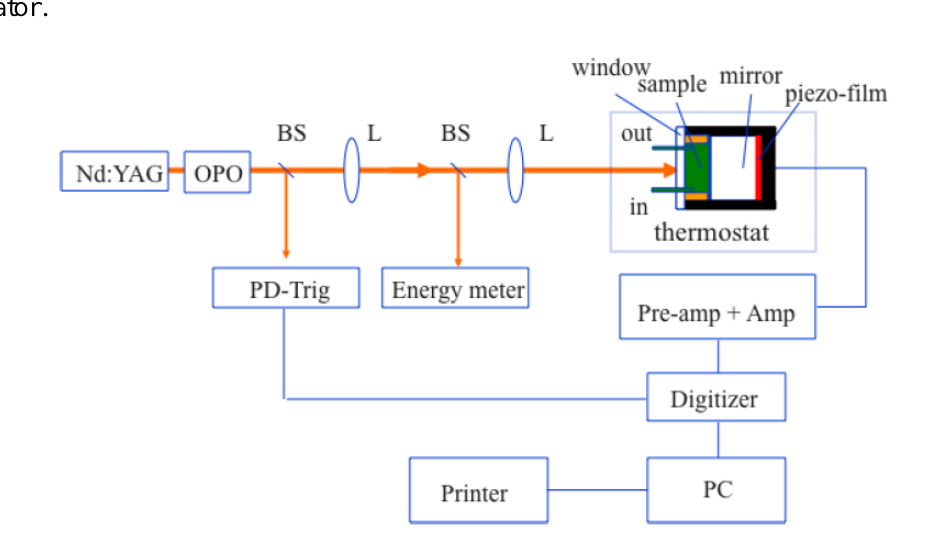
Figure 1. Block diagram of pulsed photoacoustic system on the nanosecond-microsecond time scale. BS = beam splitter, L = lens, Amp = amplifier, OPO = optical parametric